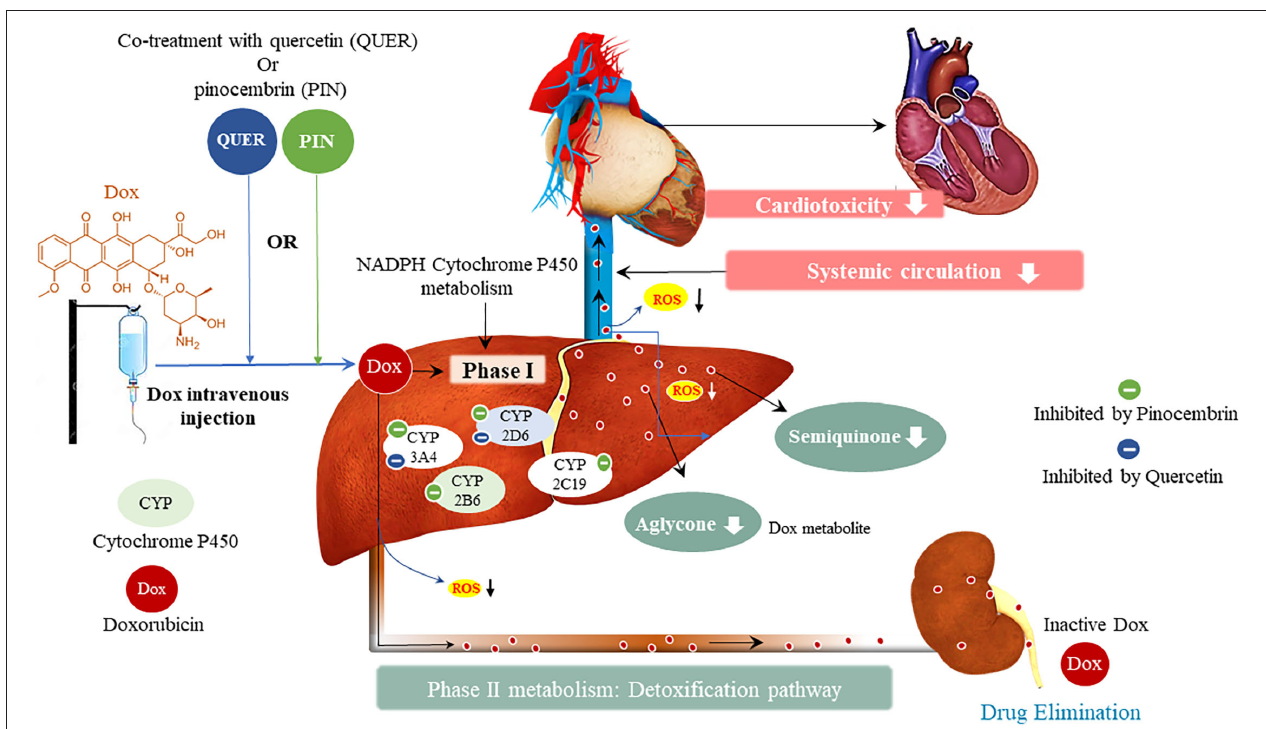
FIGURE 8 | Metabolism of doxorubicin (Dox) and resultant Dox-induced cardiotoxicity, and the potential effect of pinocembrin and quercetin on Dox metabolism. Cytochrome P450 (CYPs) enzymes allow us to predict the pharmacokinetic and pharmacodynamic variability that may exist in novel therapeutics. Doxorubicin inhibits CYP2D6, CYP2C19, and CYP2B6, whilst inducing CYP3A4. The interaction of Dox with these metabolizing enzymes formulates the toxic metabolites semiquinone and aglycone, which induce cardiotoxic side